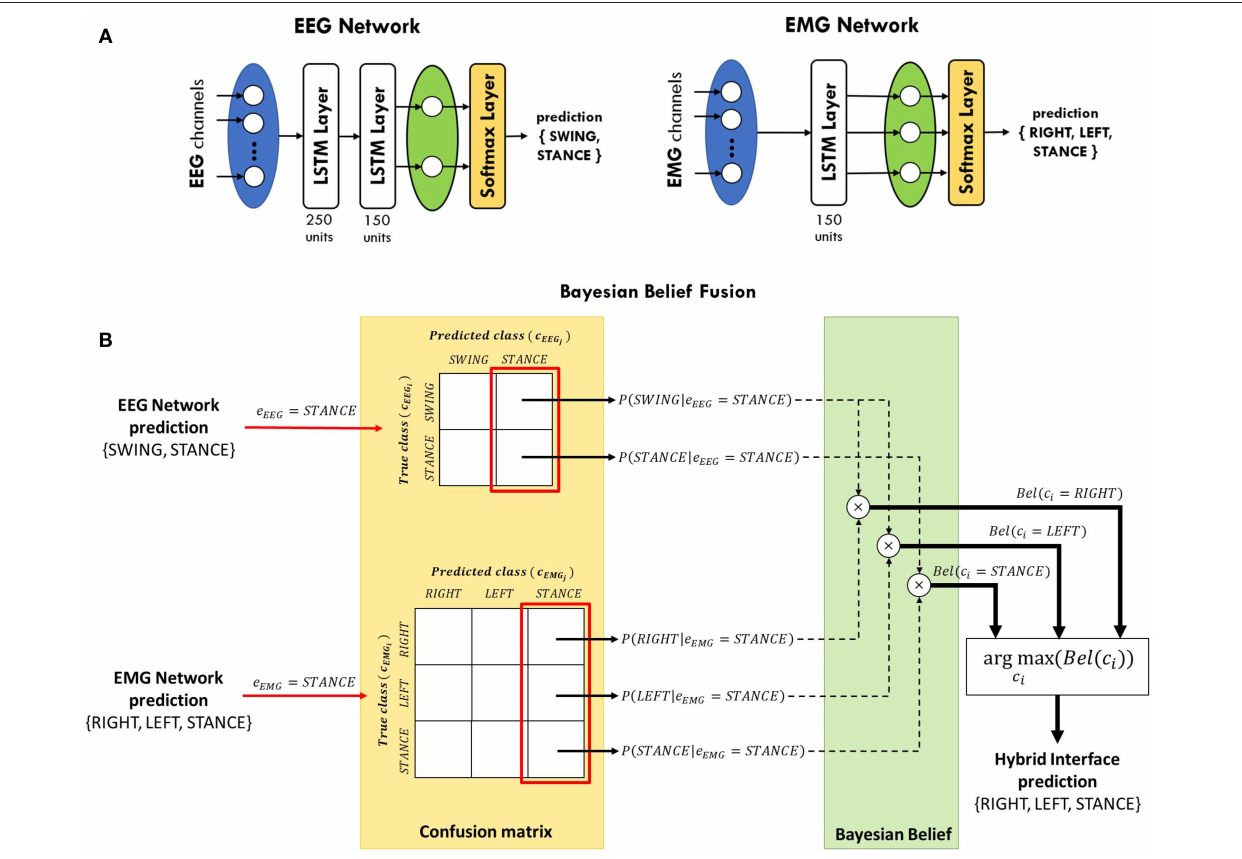
FIGURE 3 | (A) LSTM networks’ architecture for gait decoding from EEG and EMG signals. The EEG network consists of two LSTM layers, with 250 and 150 units, respectively. The output of the last layer is then processed by a fully-connected layer (green oval) and a softmax layer in order to classify between swing and stance phases. The EMG network contains only one layer with 150 units and it classifies between right swing, left swing, and stance phases. (B) Schematic diagram of Bayesian belief fusion of EEG and EMG networks classification, for a sample scenario in which both EEG and EMG networks predict the STANCE class. The output of each classifier ( e EEG , e EMG ) is used to determine the conditional probability of each true class ( c EEG matrix of each classifier, estimated during the validation phase. The Bayesian belief Bel ( c i ) of each class c i is computed by multiplication of the conditional probabilities of the EEG and EMG classifiers. The class predicted by the hybrid interface is the one maximizing the Bayesian